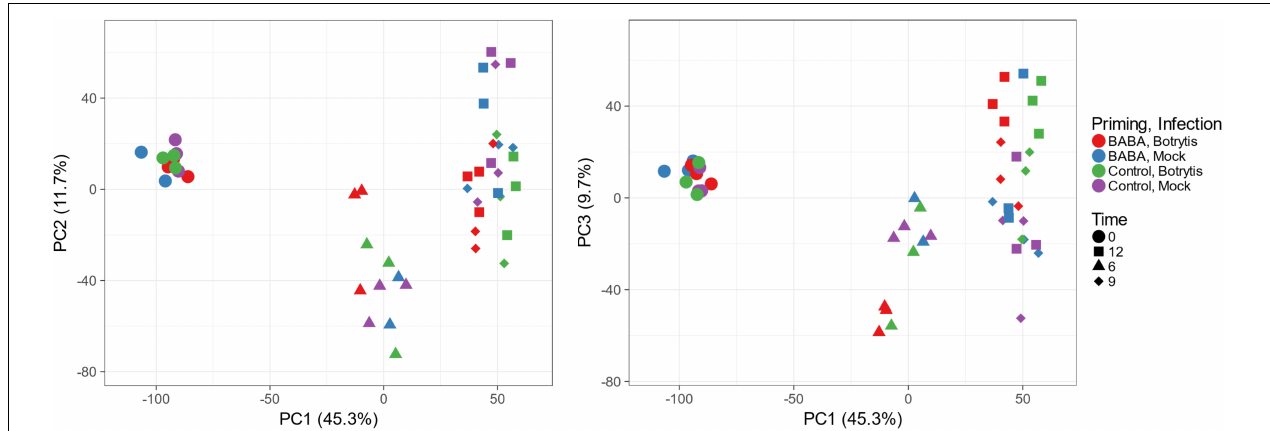
FIGURE 3 | Principal component analysis of transcriptomic responses to Botrytis cinerea infection in leaves of control and BABA-primed tomato plants. PCA was performed using the Affymetrix signals from the 7767 probe sets remaining after initial filtering. Each data point represents a single RNA sample, collected from a pool of 16 inoculation sites from two leaves each from two independent plants. Colours are used to identify treatment and the different shapes indicate time points after inoculation.